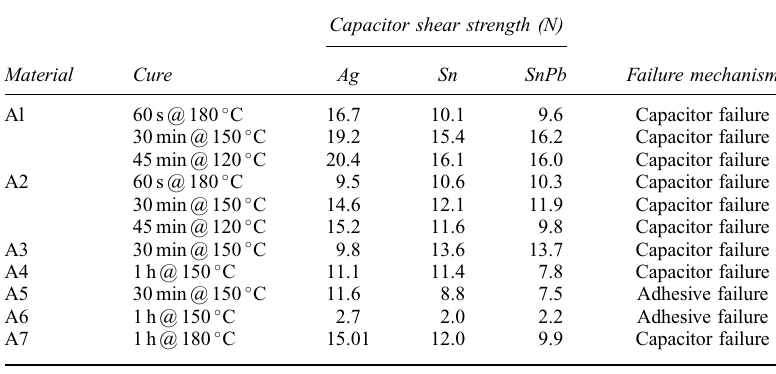
TABLE III Shear Strength (B-Case Capacitors) of Silver Adhesives on Different